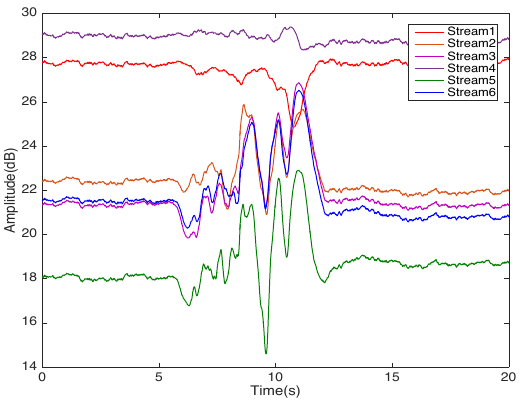
Figure 4. Raw CSI aggregated subcarriers represented by six